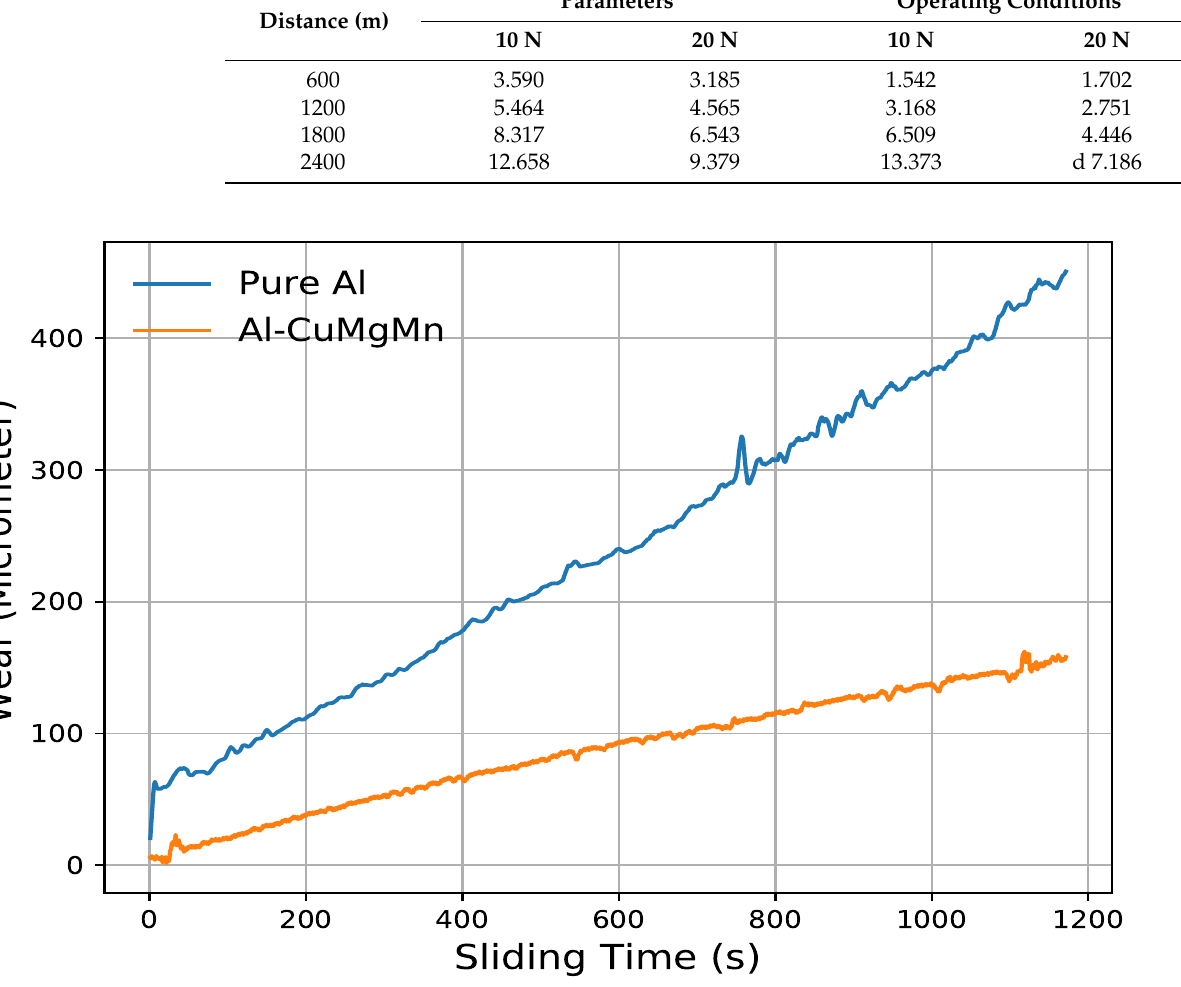
Figure 13. Comparison of coefficient of friction for substrate material and laser surface alloyed samples when 20 N load and 2 m/s sliding speed are used taking the measurements for the five cycles. Increment coefficient of friction also observed by Nath et al. [40,41] as the result of alloying of aluminum with NiCr+CO+WC+ (where the ratio of 15:70:70 by weight). Asperity model shows that softer materials have less frictional resistance; as the hardness decreases, the plasticity index increases causing a decreases in the coefficient of friction. However,